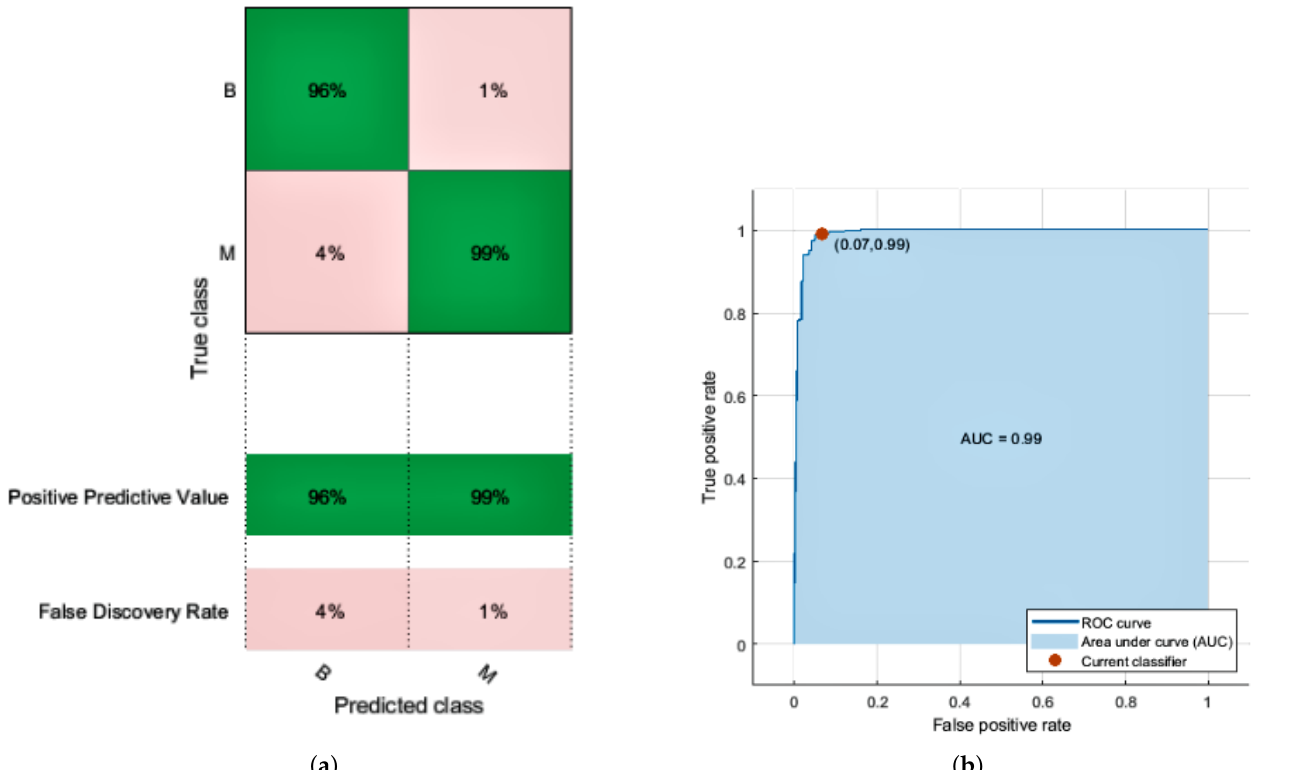
Figure 3. Results of K-Nearest Neighbor. ( a ) Confusion matrix; ( b ) AUC of KNN. The logistic regression model’s perimeters are estimated using LR classification.